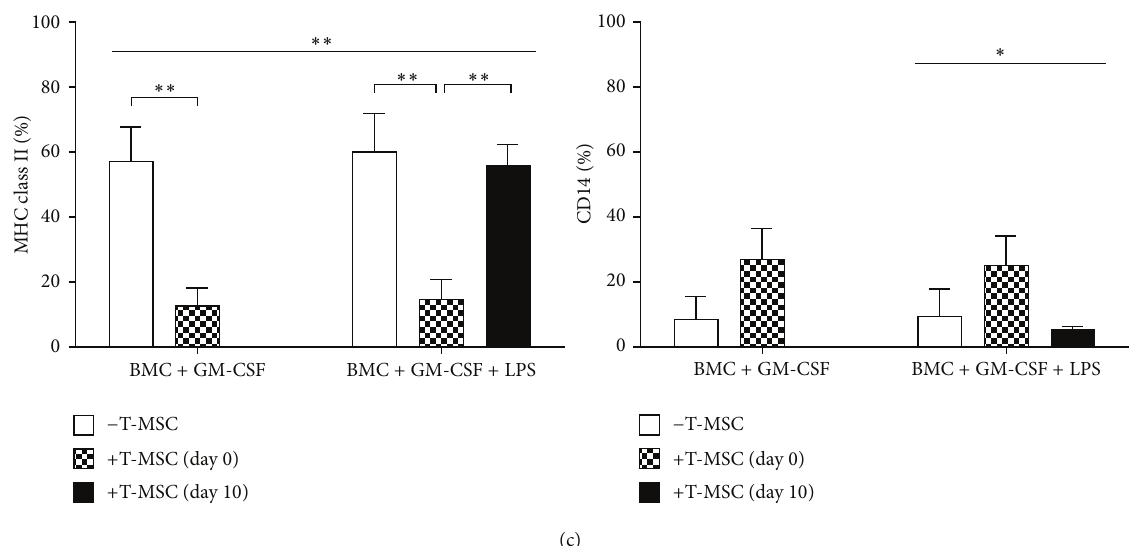
Figure 2: T-MSCs inhibit differentiation and maturation of DCs by secretion of soluble factors. (a) BMCs and T-MSCs were cultured in a transwell plate and BMCs were induced to differentiate into DCs by GM-CSF. (b) BMCs differentiation into CD11b + cells was inhibited by T-MSCs added at day 0 ( ∗∗ 𝑃 < 0.01 ). (c) CD86 expression on mature DCs was significantly downregulated by T-MSCs ( ∗∗ 𝑃 < 0.01 ). Similar to the coculture condition, MHC class II expression on immature and mature DCs was inhibited by factors secreted from T-MSCs ( ∗∗ 𝑃 < 0.01 ). CD14 expression by T-MSCs showed a trend toward increase, but it was not